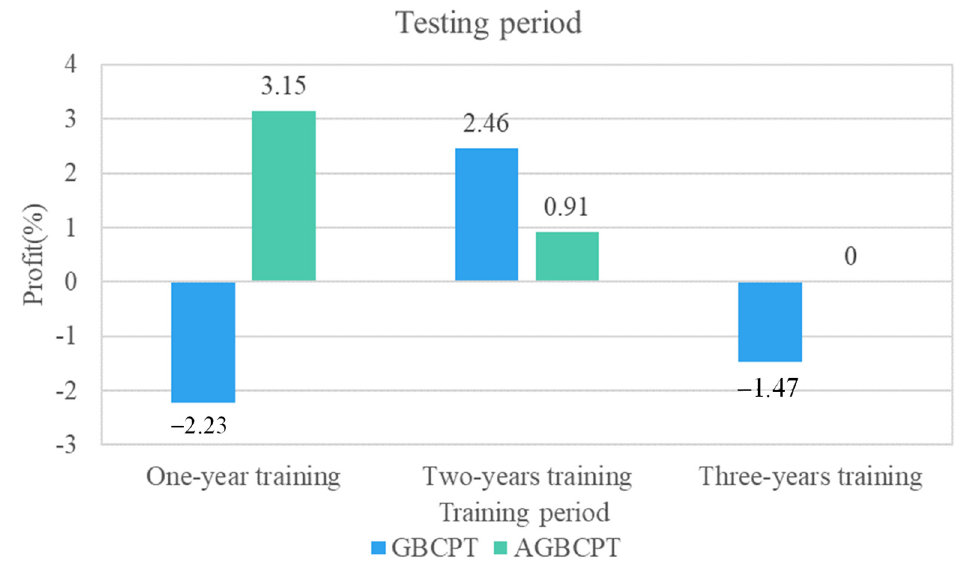
Figure 15. AGBCPT and GBCPT profits in testing phase.